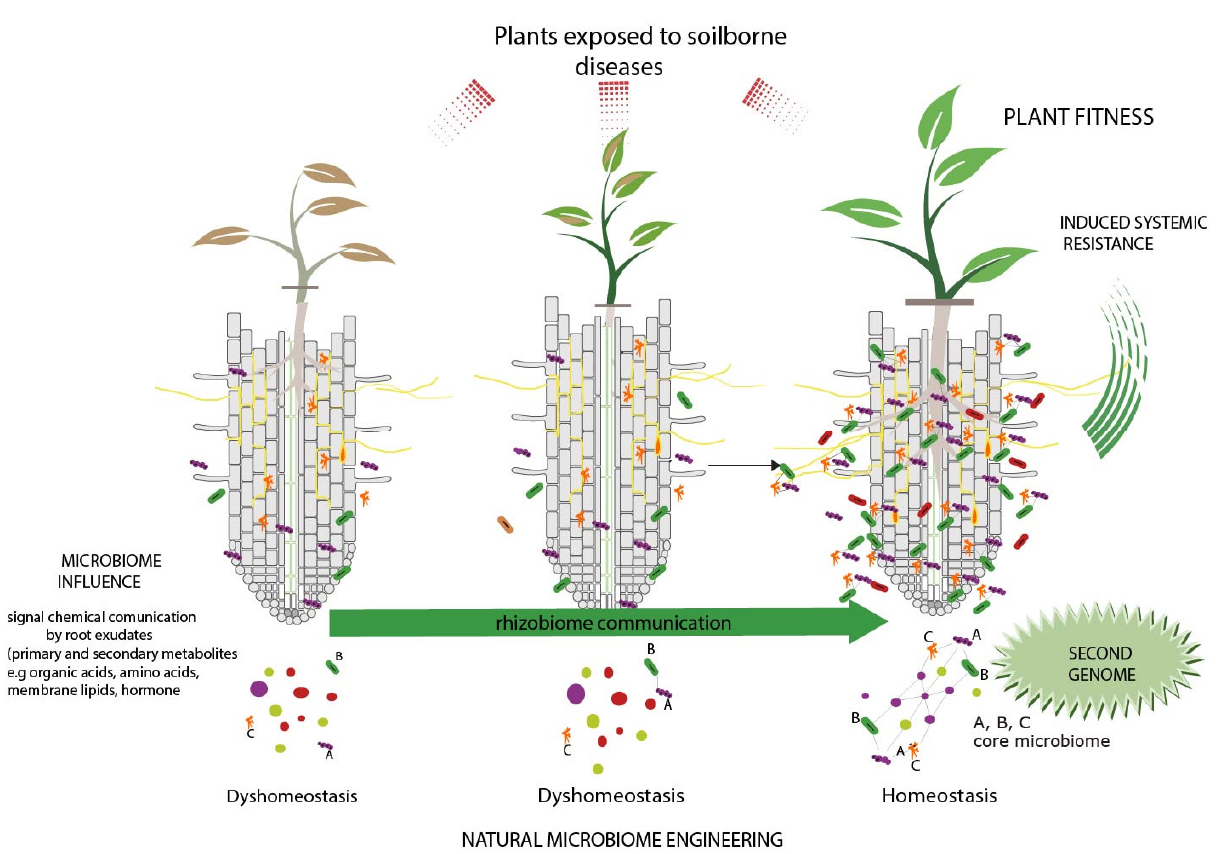
Figure 3. Plants exposed to soilborne disease recruit a specific microbiome (core microbiome or microbial hubs) induced by a chemical signal to induce microbiome homeostasis.